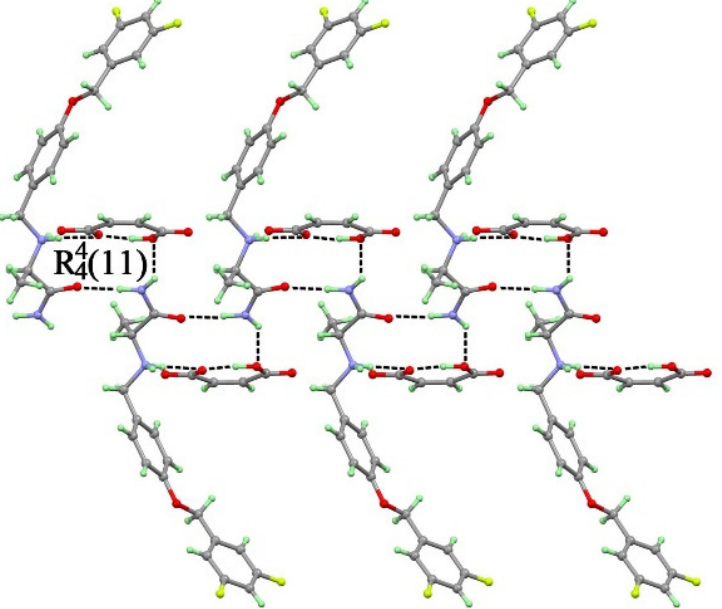
Figure 4. SAF cations and maleic acid (MA) anions form a R 4 O5–H5 ··· O4, N2 − H2B ··· O5, and N2 − H2A ··· O2 hydrogen